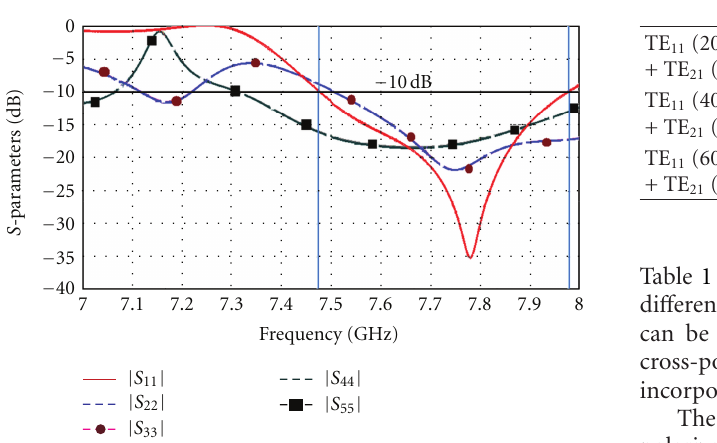
Figure 7: Reflection coe ffi cient magnitudes of the modes TE 11 , TM 01 , and TE 21 when the symmetric reflector is excited with a triple-mode feedhorn.